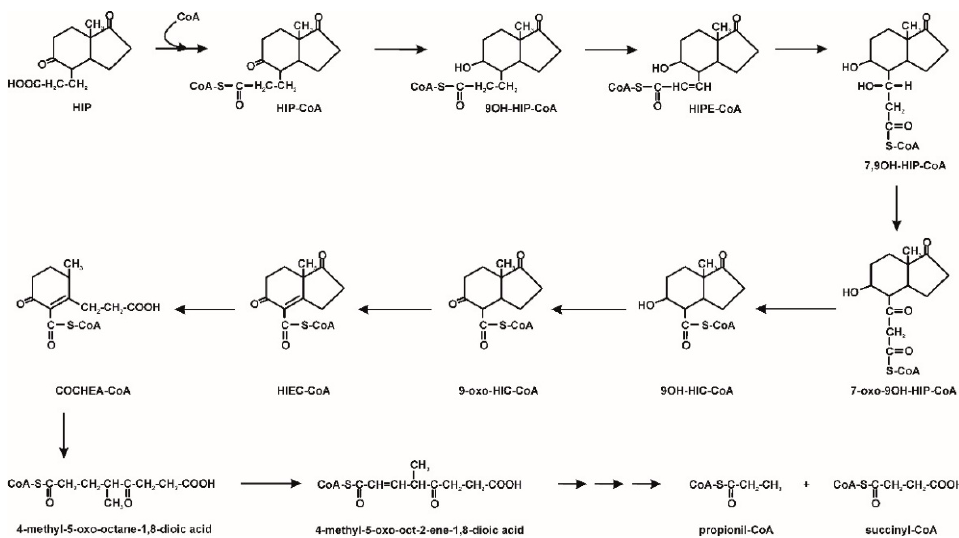
Figure 3. HIP degradation pathway; HIP – 9,17-dioxo-1,2,3,4,10,19-hexanorandrostan-5-oic acid; HIP-